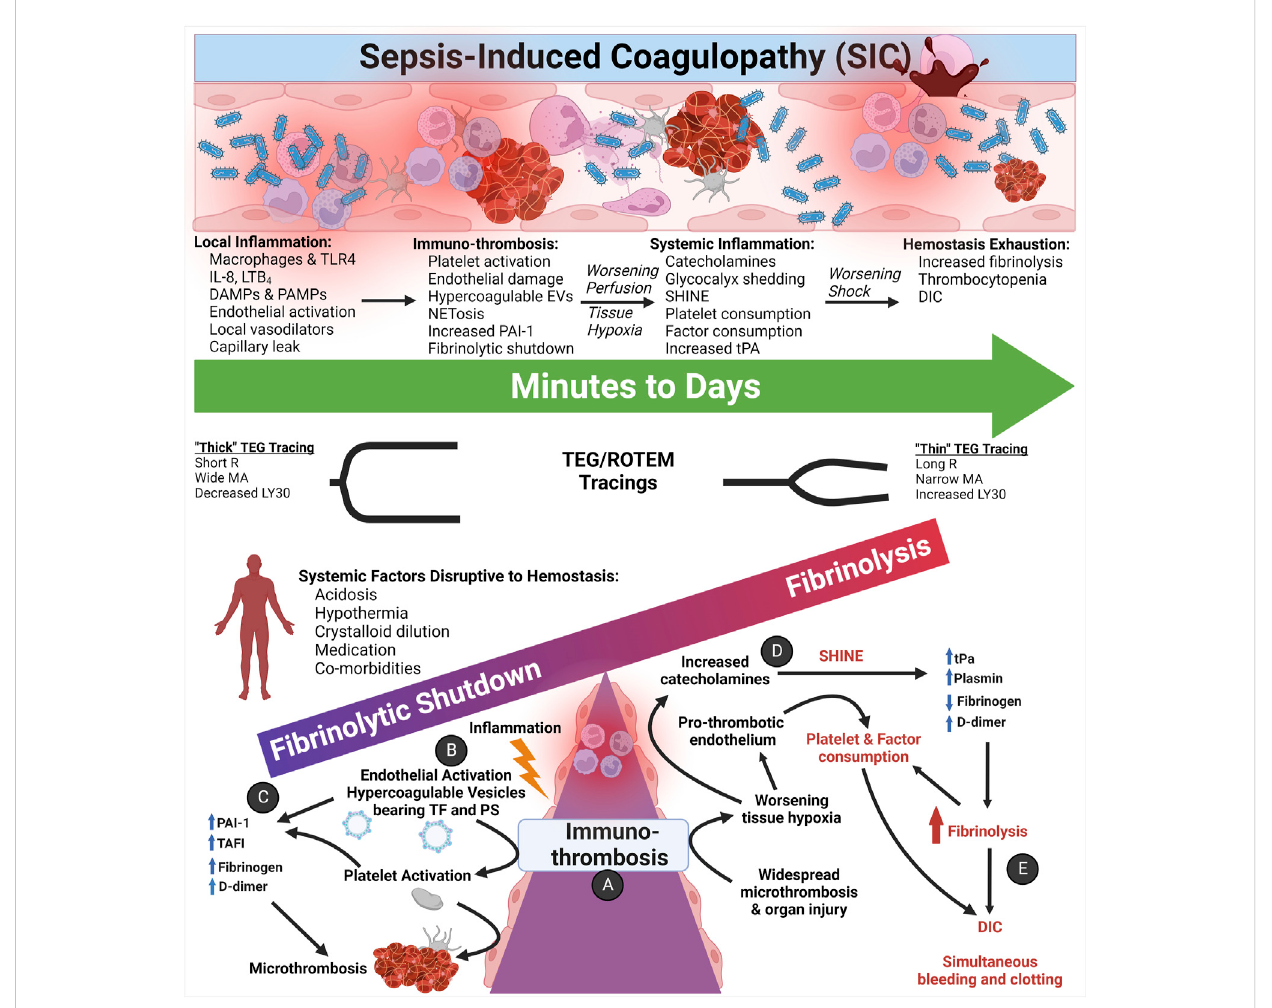
FIGURE 9 The Coagulo fi brinolytic Spectrum of Sepsis-induced Coagulopathy (SIC) Pertaining to Immuno-thrombosis and SHINE. (A) Initially, the immuno- thrombosis manifests as microthrombosis within the microvasculature. (B) In fl ammation activates the endothelium and, among other mechanisms, activates primary and secondary hemostasis via the endothelial release of hypercoagulable circulating extracellular vesicles (EVs) bearing Tissue Factor (TF) and phosphatidylserine (PS). (C) Most patients with SIC present with hypercoagulopathic, hypo fi brinolytic thromboelastography (TEG)/ rotationalthromboelastometry(ROTEM)tracingswithelevatedacutephasereactantssuchas fi brinogen,D-dimer,andplasminogenactivatorinhibitor-1 (PAI-1).QuiescentplateletscontainPAI-1,TAFI,FXIIIa,and α 2-antiplasminin α -granules,anduponactivation,plateletsreleasePAI-1to complexwith and inhibit action of tPA. Thrombin may also provoke release of PAI-1 from the endothelium (Huebner et al., 2018). (D) As hypoperfusion and the shock state progresses, increased catecholamines activate and damage the pro-thrombotic endothelium, causing systemic endothelial release of Weibel-Palade bodies containing tPA.Hypoperfusion also increases endothelial calciumin fl ux,resultinginPS exposure ontheendothelialluminal surface. (E) Increased circulating tPA tips the scales in favor of fi brinolysis as a counterbalance to the widespread microthrombosis. Thus, a small percentage of septic patients may present and/or progress to a hyper fi brinolytic and consumptive hypocoagulopathic state of disseminated intravascular coagulation (DIC), which requires aggressive resuscitation with primarily blood components as opposed to crystalloid fl uids for the hypercoagulopathic SIC patients (Levi and van der Poll, 2017; Iba and Ogura, 2018; Iba et al., 2019b; Bunch et al., 2022b). Abbreviations: DAMPs, Damage-Associated Molecular Patterns; DIC, Disseminated Intravascular Coagulation; EVs, Extracellular Vesicles; IL-8, Interleukin-8; LTB4, Leukotriene B4; LY30, Lysis at 30 min; MA, Maximum Amplitude; PAI-1, Plasminogen Activator Inhibitor-1; PAMPs, Pathogen-Associated Molecular Patterns; PS, PhosphatidylSerine; R, Reaction time; SHINE, SHock-INduced-Endotheliopathy; TAFI,Thrombin-ActivatableFibrinolysis Inhibitor; TF,Tissue Factor; TLR,Toll-Like Receptors;tPA, tissue Plasminogen Activator. Created with